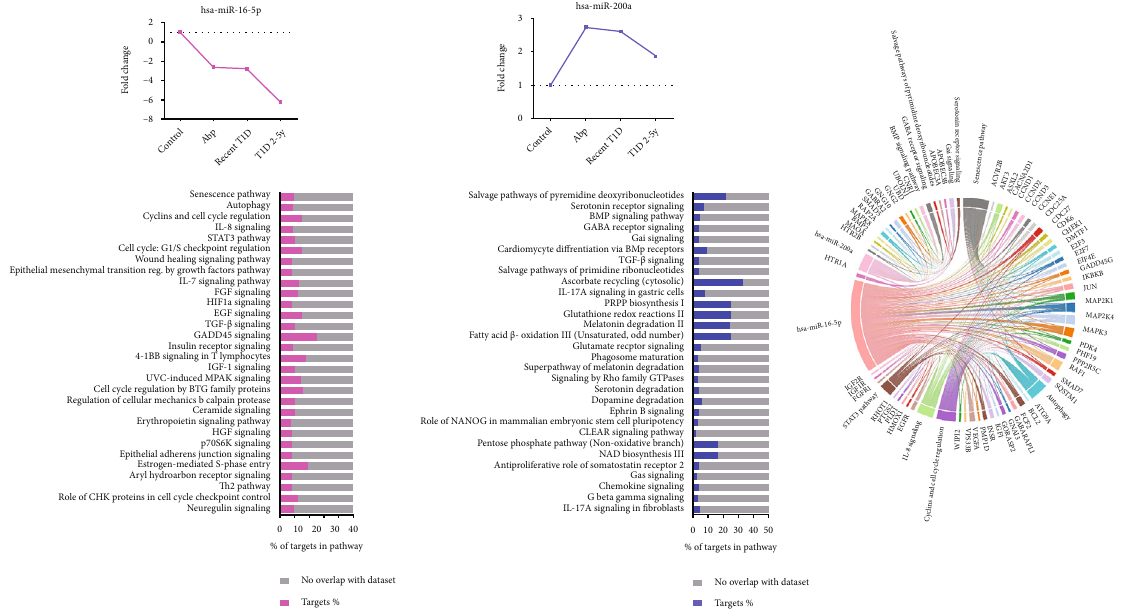
Figure 7: miR-16-5p and miR-200a-3p: serum levels expressed during T1D progression and canonical pathways most signi fi cantly enriched by serum miRNAs through Ingenuity Pathway Analysis (IPA). AbP group (individuals with islet autoantibodies without diabetes; n = 25 ), recent-onset type 1 diabetes (T1D) group (newly diagnosed T1D patients with duration ≤ 6 months; n = 30 ), and T1D 2-5y group (patients with T1D with 2 to 5 years of duration; n = 26 ) in comparison with health controls. The stacked bar chart displays the percentage of target DEGs molecules present in each pathway. The Benjamini-Hochberg method was used to adjust the right-tailed Fischer ’ s exact test p value, which was always <